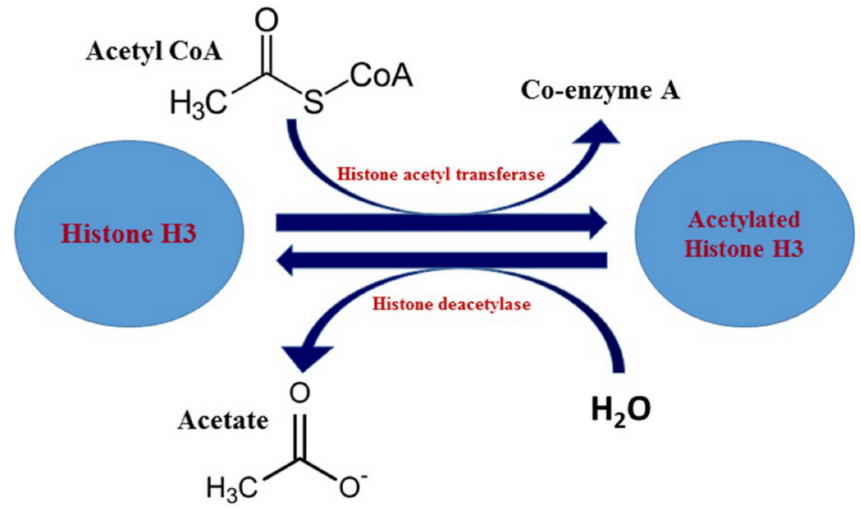
Figure 3. Chemical reactions involved in histone acetylation